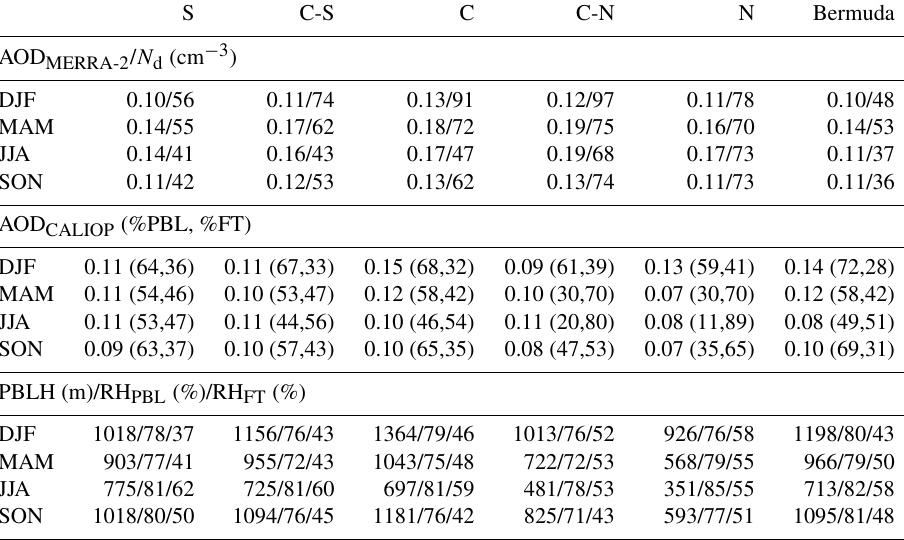
Table 3. Average drop number concentration ( N d ), MERRA-2 AOD, and vertically resolved AOD characteristics from CALIOP for each season over the sub-domains shown in Fig. 2. Total CALIOP AOD is shown outside parentheses, and numbers inside are the percent AOD fraction in the planetary boundary layer followed by in the free troposphere. Also shown are PBLHs (shown in Fig. 4) and the relative humidity in the PBL and